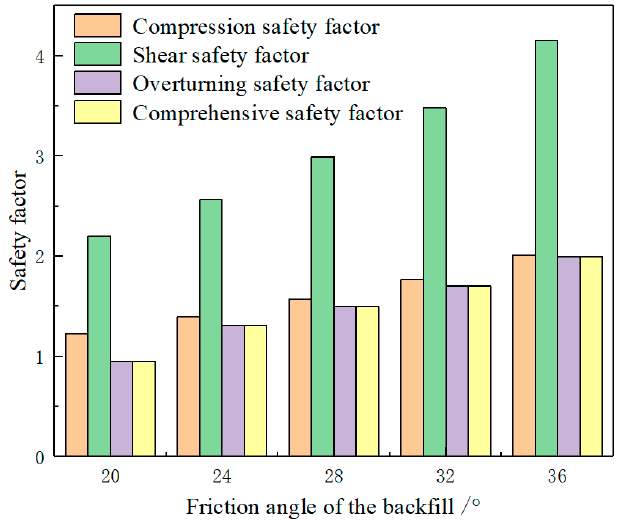
Figure 5. Relationship between safety factor and friction angle of the backfill.